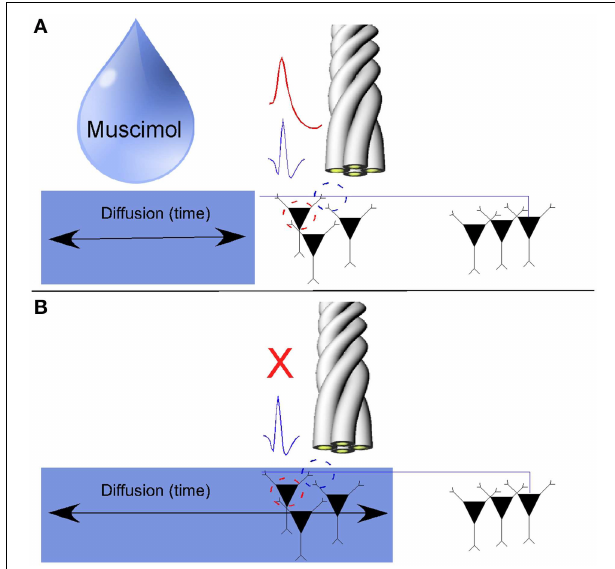
FIGURE 2 | Pharmacological separation of axonal activity from somatic activity using the GABAa agonist Muscimol. (A) Somatic action potentials and axonal activity were simultaneously on the same tetrode. (B) Somatic action potentials were inactivated over time as muscimol diffused through the hippocampus. As axons tend to have a sparse density of GABAa receptors, axonal activity persisted while simultaneously recorded cells on the same tetrode were inactivated (Adapted with permission from Ramón y Cajal,